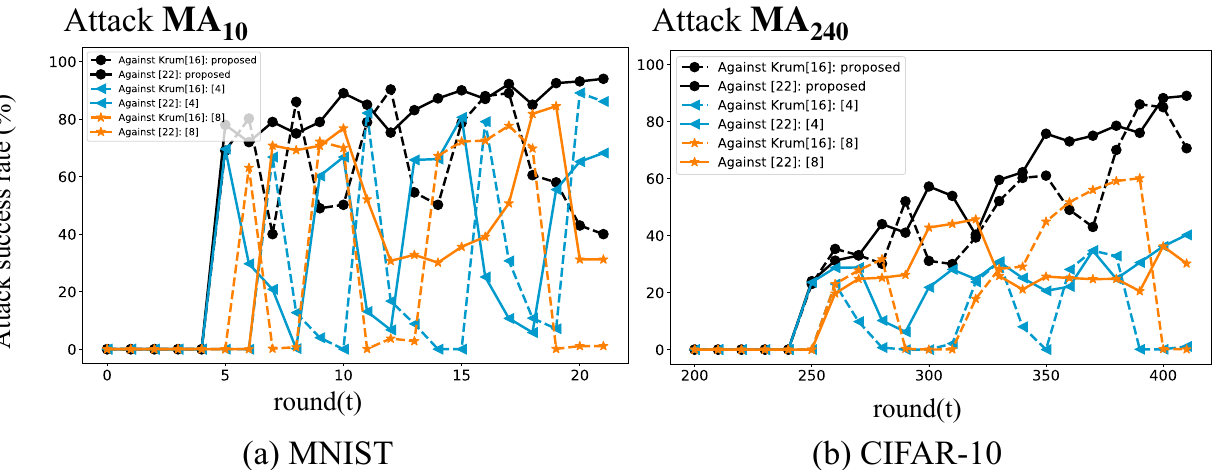
Figure 6. Comparison of attack success rate (i.e., accuracy for adversarial task) between the proposed attack, model poisoning [8] and the backdoor attack proposed in [4] against defense methods in [16,22].